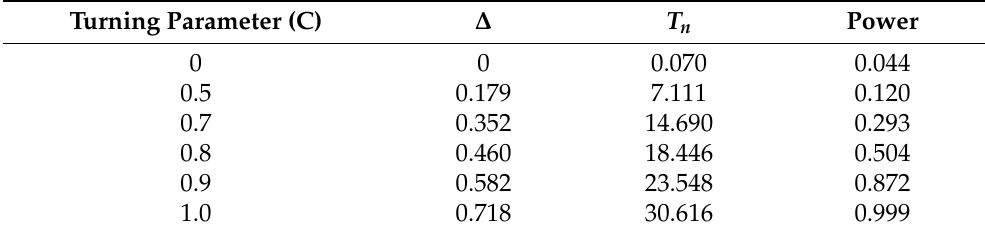
Table 1. Power/type I error of T n -based simulated 10,000 replications. Turning Parameter (C)